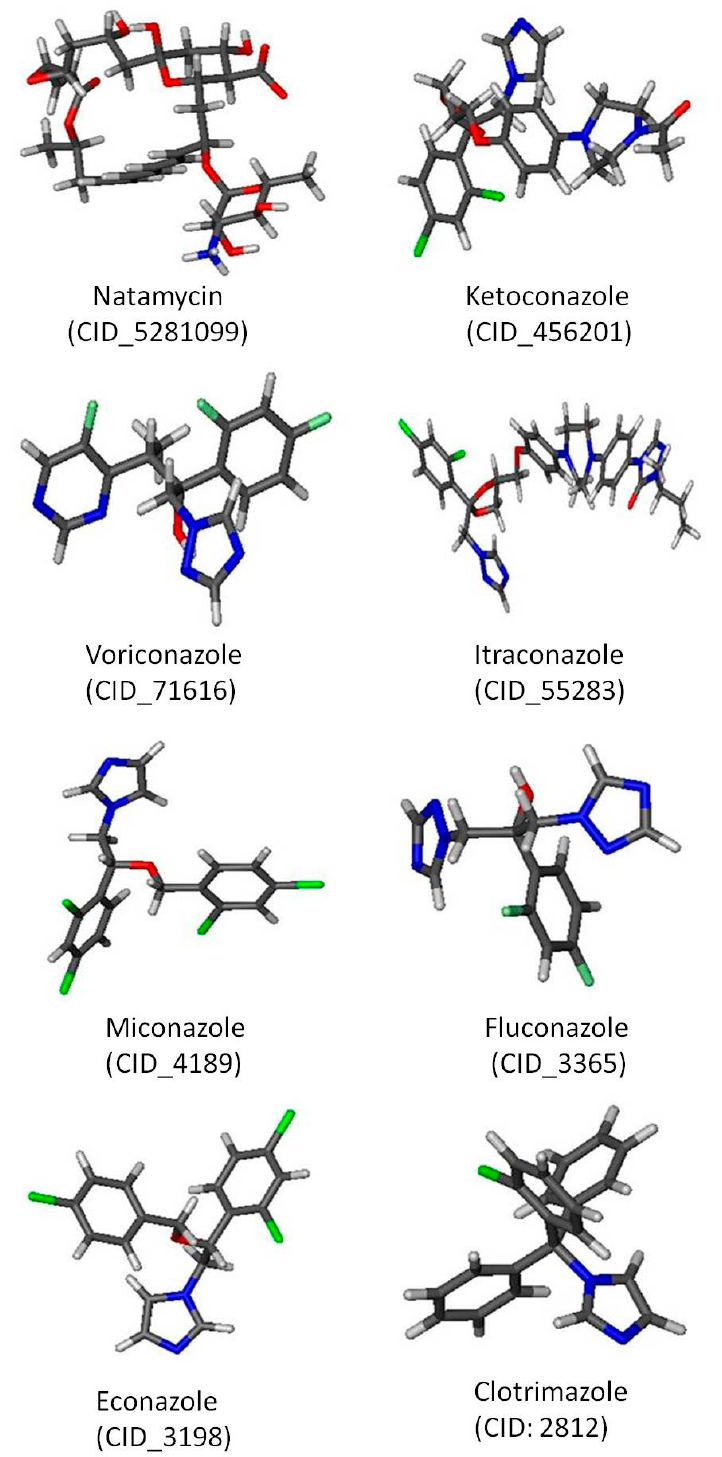
Figure 3. The 3D structures of eight anti-fungal compounds, along with their pubchem IDs.